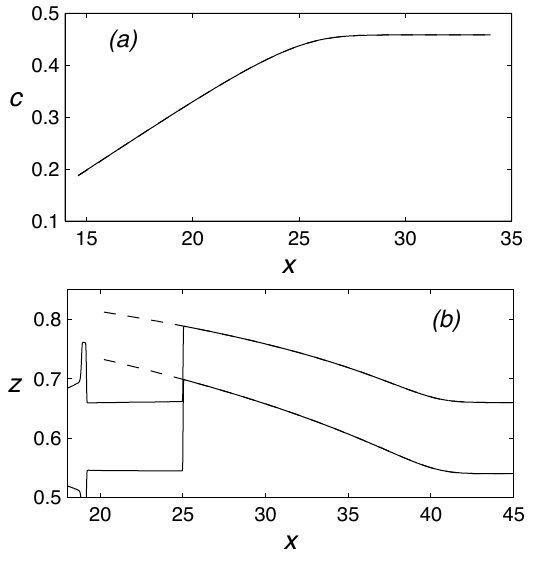
Fig. 4. (a) Speed of propagation of points on each interface, c , at t = 30 from Fig. 3. Speeds of the lower and upper interfaces are indicated by solid and dashed lines, respectively. At the magnifica- tion of the plot these two curves are indistinguishable. (b) Close-up of the interface positions (solid lines) from the numerical solution in Fig. 3 at t = 60. Also shown (dashed lines) are the interface posi- tions assuming simple wave behavior from Eq. (30) with c(ξ) from (a) . The numerical and simple wave lines are nearly indistinguish- able on the the leading part of the wave ( x > 25).